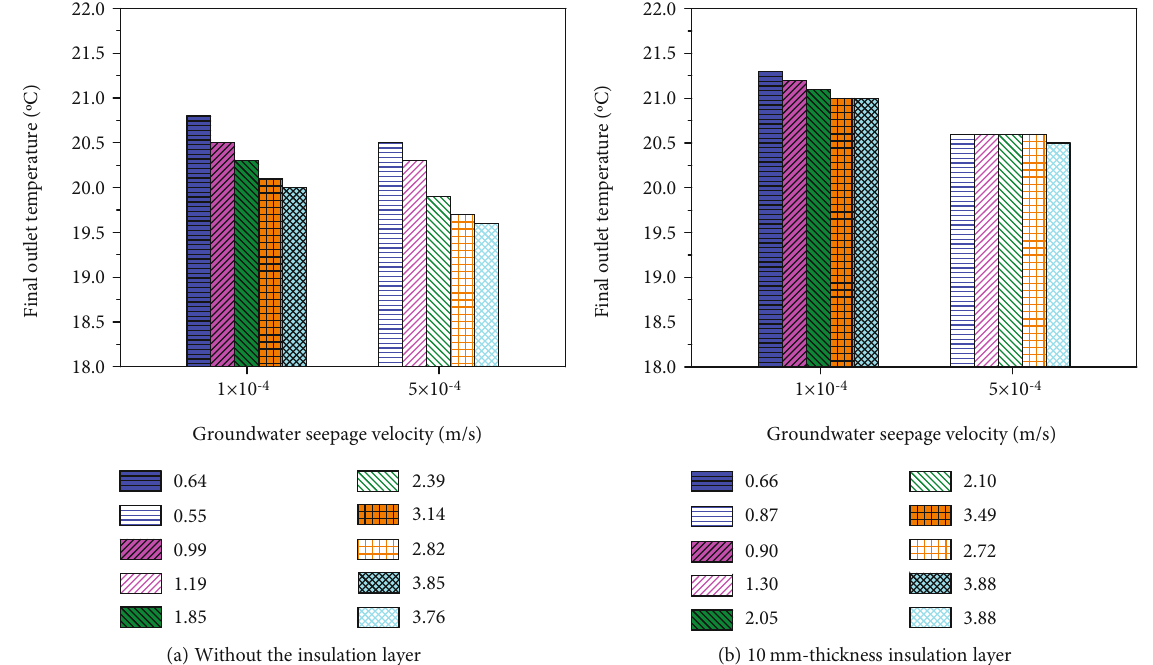
Figure 10: Relationship between fi nal outlet temperature of GHEs and groundwater seepage velocity at various wind speeds.